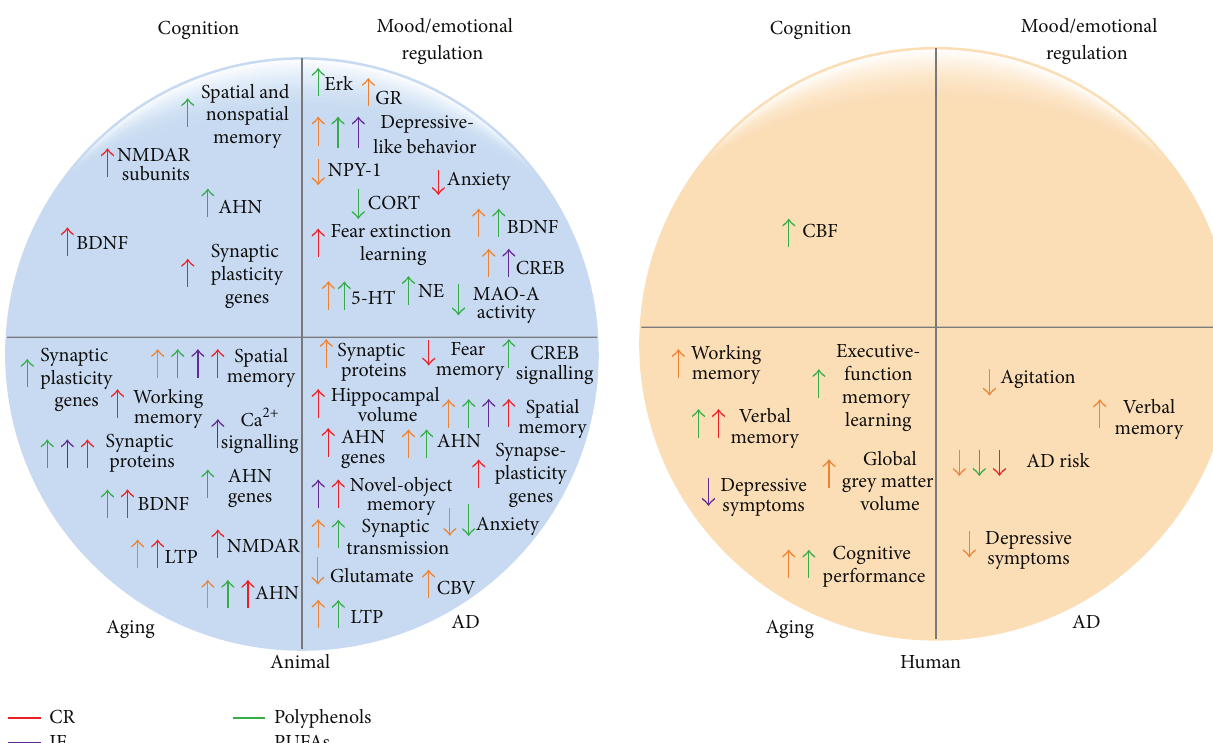
Figure 1: Different dietary interventions in animal and human studies are believed to modulate various aspects of brain plasticity and in turn influence behaviour. Animal studies provide the vast majority of our current mechanistic understanding of the potential mechanisms by which dietary interventions impact brain plasticity. Further mechanistic studies aiming to fill the gap in our understanding of how diet can modulate plasticity and promote mental health in human populations are clearly needed. Moreover, additional intervention studies are also required to demonstrate efficacy, enabling the safe translation of such dietary interventions into clinical practice or incorporated into our daily lifestyles to enhance brain health/function and well-being. In red, effects induced by CR; in purple, effects induced by IF; in green, effects induced by supplementation with polyphenols; in orange, effects induced by PUFAs. AD: Alzheimer’s disease; AHN: adult hippocampal neurogenesis; BDNF: brain-derived neurotrophic factor; CBF: cerebral blood flow; CBV: cerebral blood volume; CORT: corticosterone; CR: calorie restriction; CREB: cAMP responsive-element binding; 5-HT: 5-hydroxytryptamine; IF: intermittent fasting; GR: glucocorticoid receptor;LTP:long-termpotentiation;MAO-A:monoamineoxidaseA;NMDAR:N-methyl-D-aspartatereceptor;NE:noradrenaline;NPY-1: neuropeptide Y type 1 receptor; PUFAs: polyunsaturated fatty